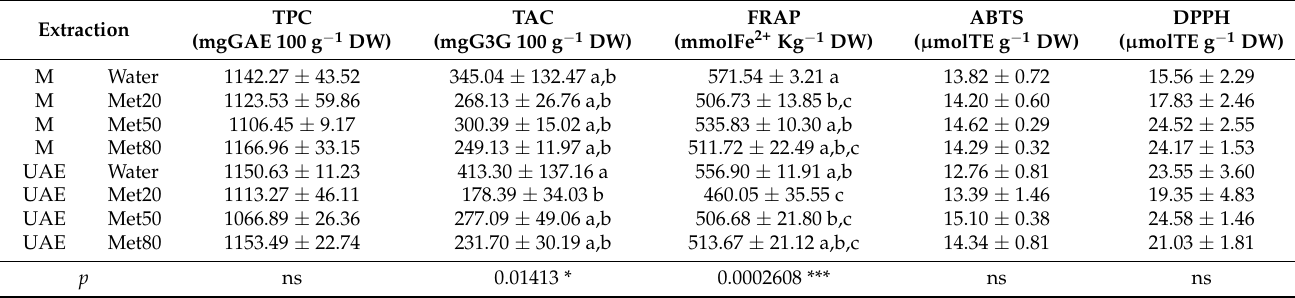
Values of mean and standard deviation are reported for each variable. Statistical comparisons were performed using ANOVA for TPC, TAC, and FRAP or the non-parametric Kruskal–Wallis test for DPPH and ABTS ( p > 0.05 in Levene’s test). Values with the same letter are